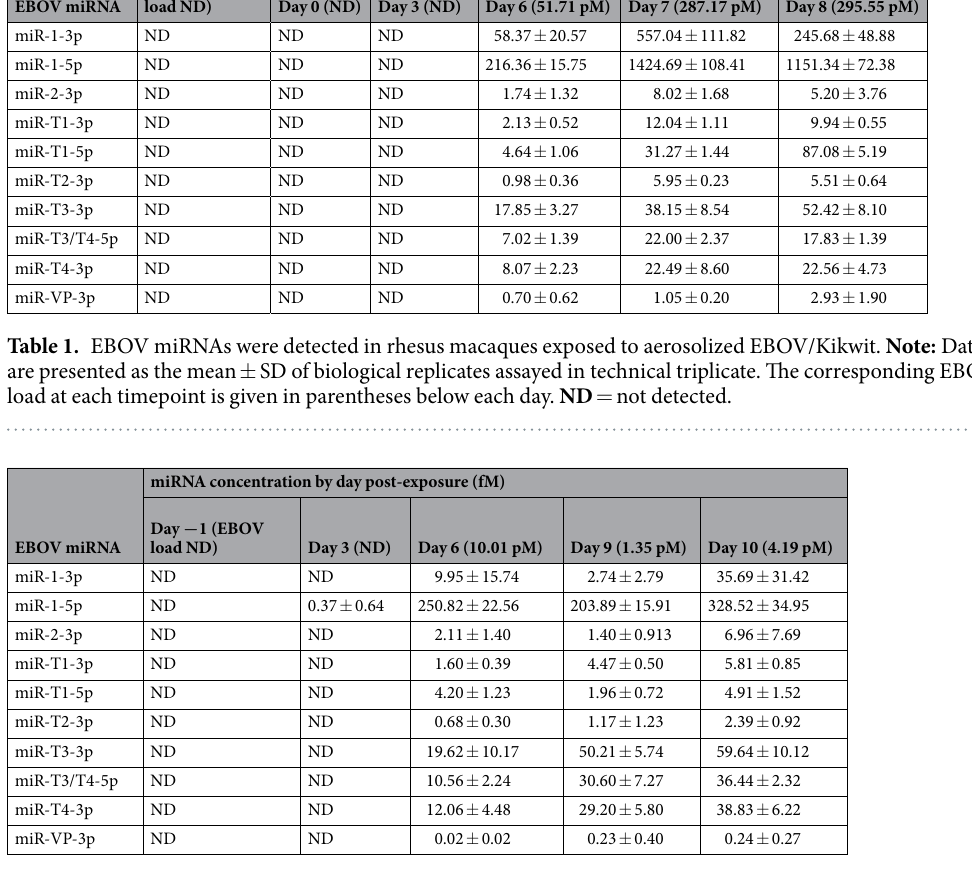
Table 2. EBOV miRNAs were detected in cynomolgus macaques intramuscularly injected with EBOV/ Makona. Note: Data are presented as the mean ± SD of biological replicates assayed in technical triplicate. Values in bold font indicate amplification in only one of three biological samples, with mean ± SD only for that sample. The corresponding EBOV load at each timepoint is given in parentheses below each day. ND = not